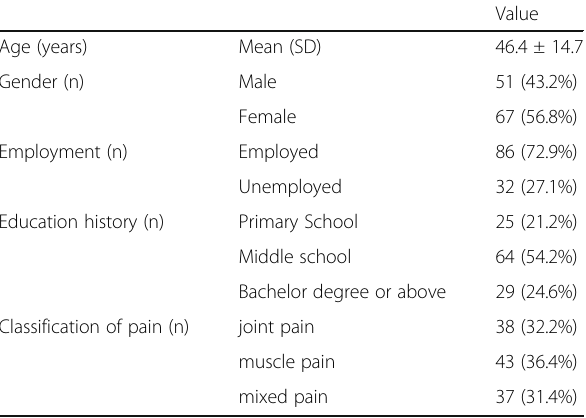
Table 1 Characteristics of patients ( n = 118)